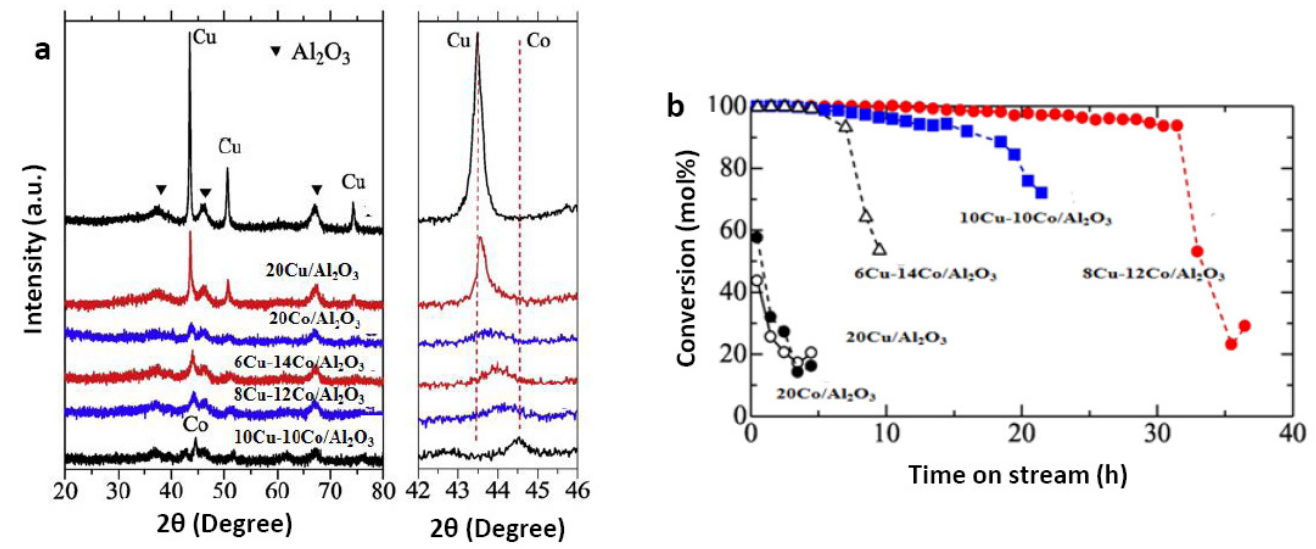
Figure 5. ( a ) XRD patterns and ( b ) change in the conversion in a long ‐ run reaction for